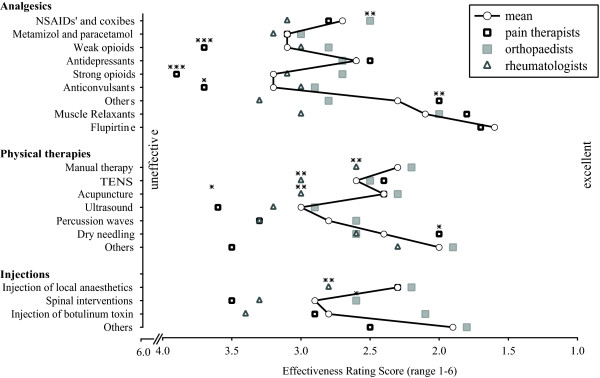
Ratings of Treatment Options. demonstrates the physician estimated efficacy of different therapeutic options in the treatment of myofascial pain on a 6-fold scale (with 1 being "excellently effective" and 6 being "ineffective"). Ratings towards the lower ranks on the value axis indicate a higher estimated effectiveness. Data are expressed as mean ± SD. (*), (**) and (***) express the different levels of significance p < 0.05, 0.01 and 0.001. Between-group differences were examined with Kruskal-Wallis tests, using the Mann-Whitney U tests for post-hoc two-group comparisons. Stars are placed upon the confirmed group, respectively. TENS: transcutaneous electrical stimulation.